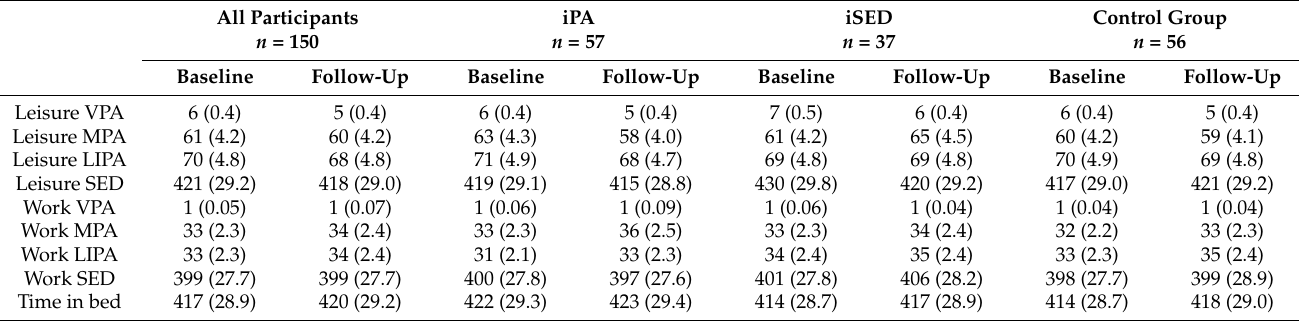
Table 3. Baseline and 6-month follow-up values for minutes spent in domain-specific 24-h movement behaviors (composi- tional mean and % of 24-h in